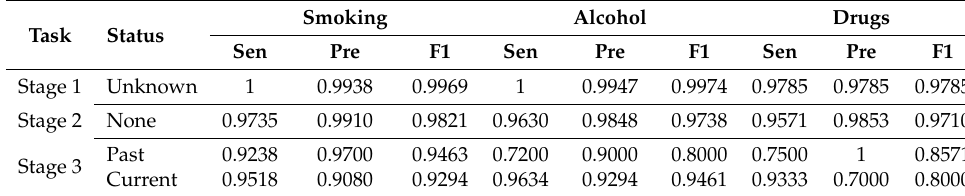
Table 6. Substance-use status-detection performance using the proposed approach.